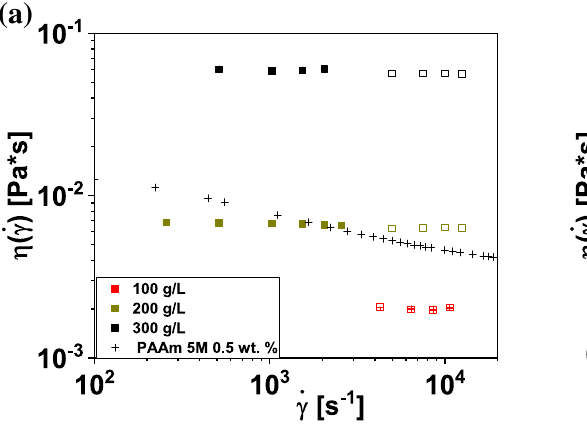
and 200 μ m Rheo-chip, respectively. In a , the shear viscosity of a 0.5 wt% solution of 5M polyacrylamide is also shown for a compari- son